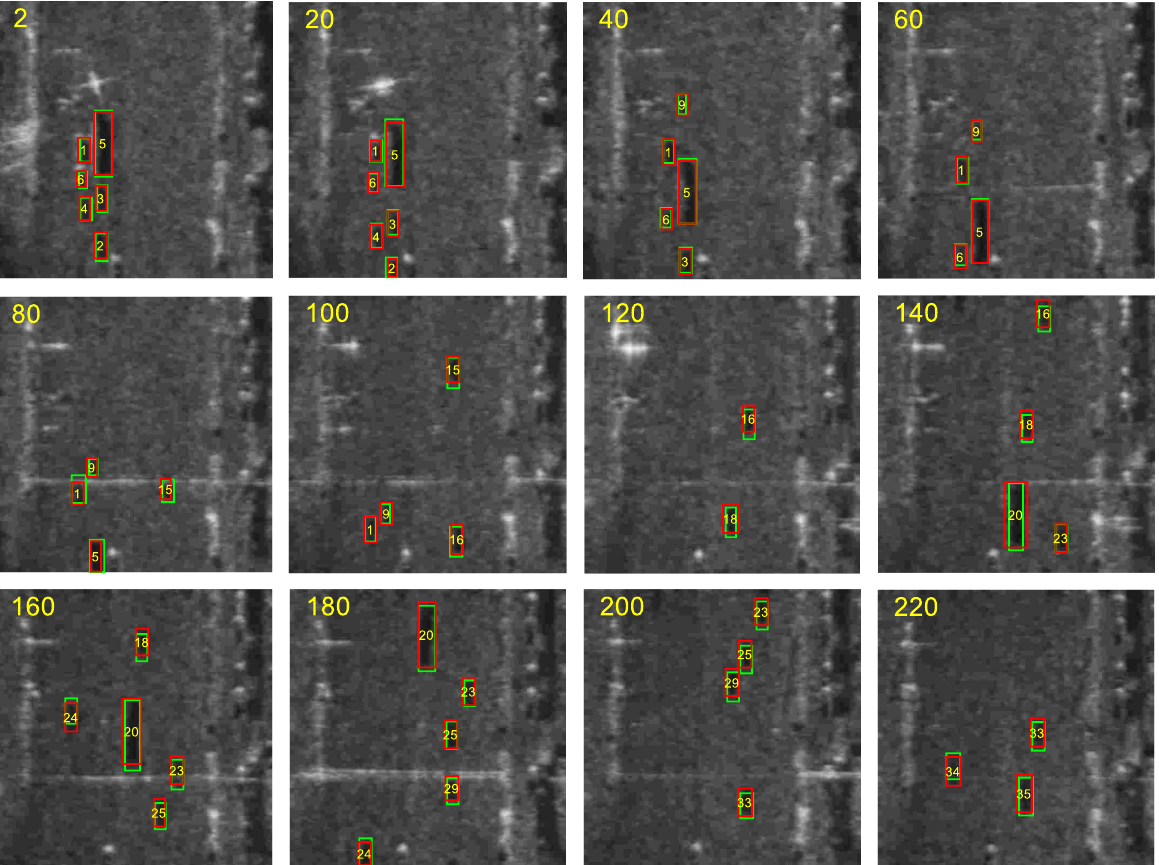
Figure 18. Tracking results obtained by Siam-SORT on twelve